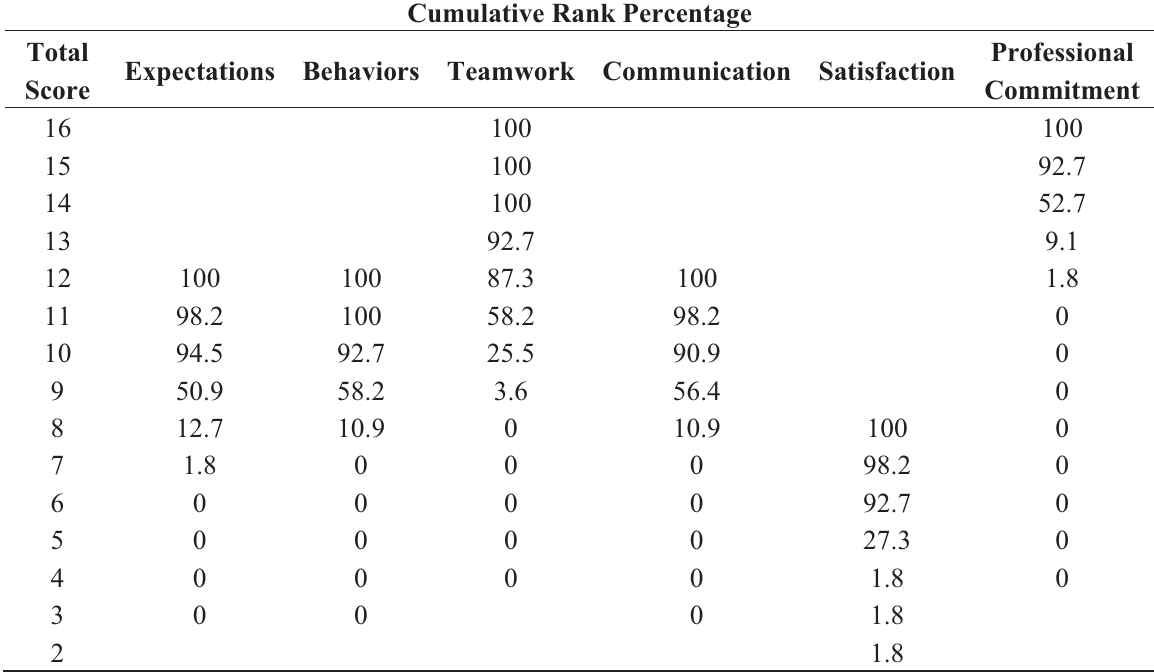
Table 4. Cumulative Rank Percentage for Each of the NCAT’s Six Subscale Total Scores. Cumulative Rank Percentage